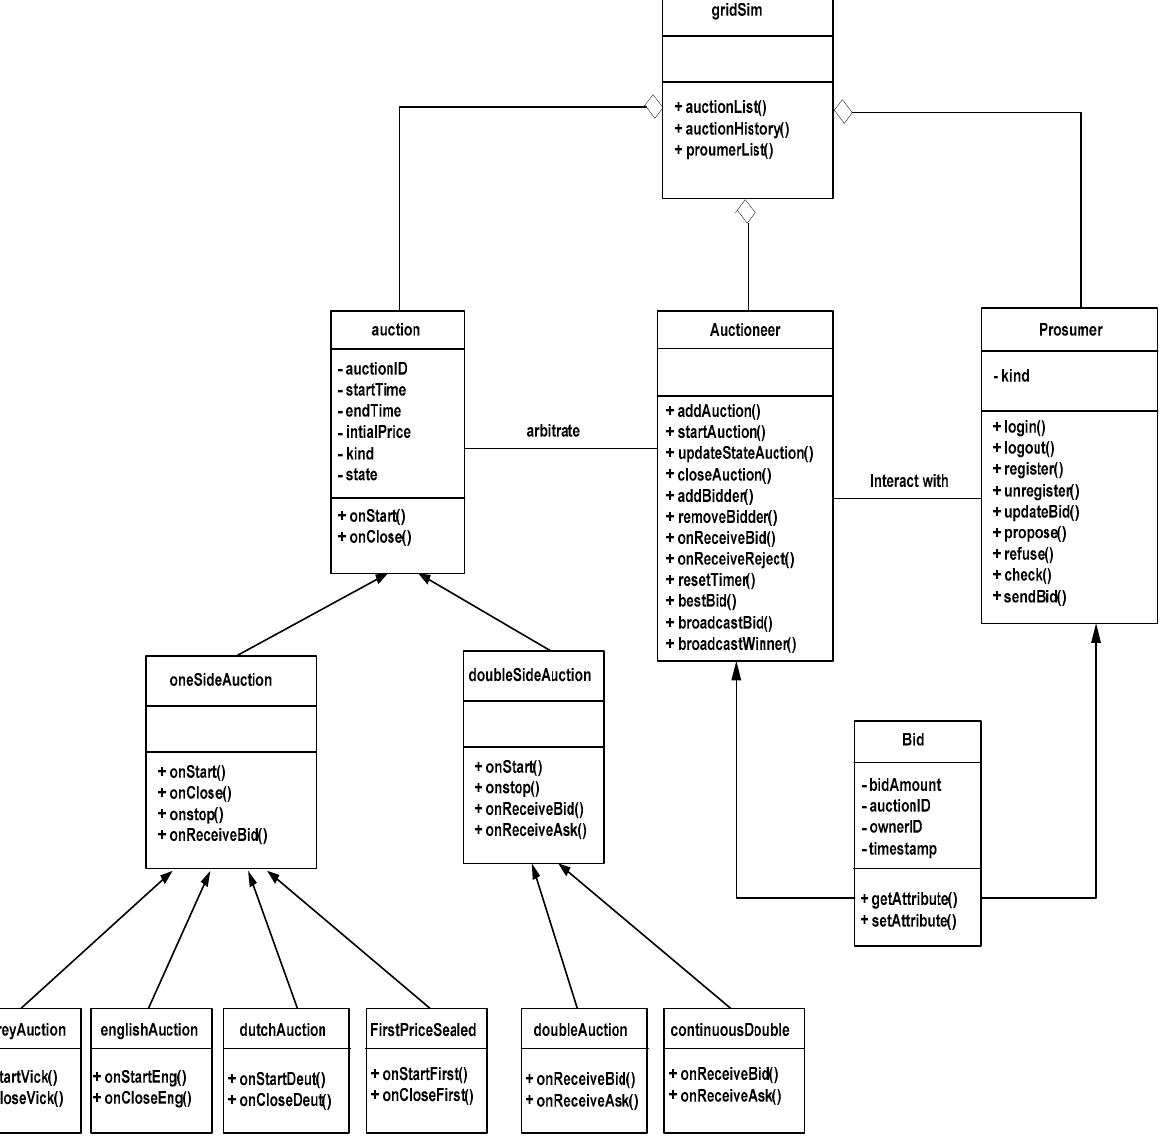
Figure 5. A class diagram of the auction framework.